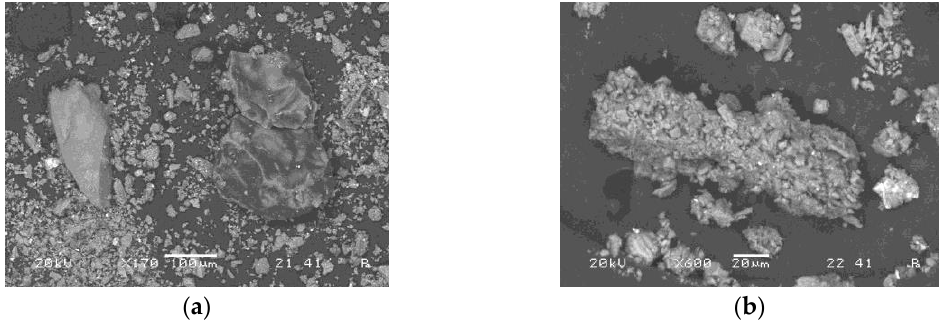
Figure 1. SEM micrographs of green waste ceramic. ( a ) General picture with rock-like particles; ( b ) aggregate.